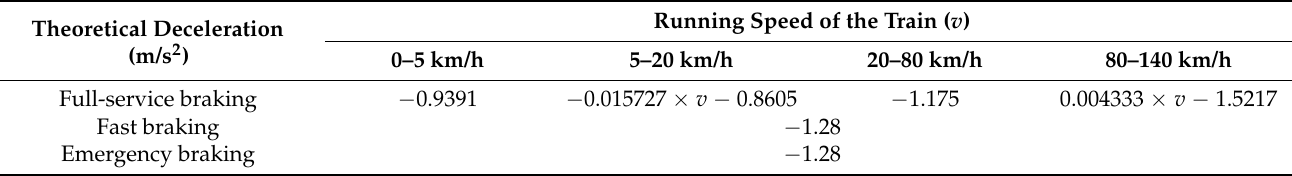
Table 1. Theoretical deceleration definition in the test.